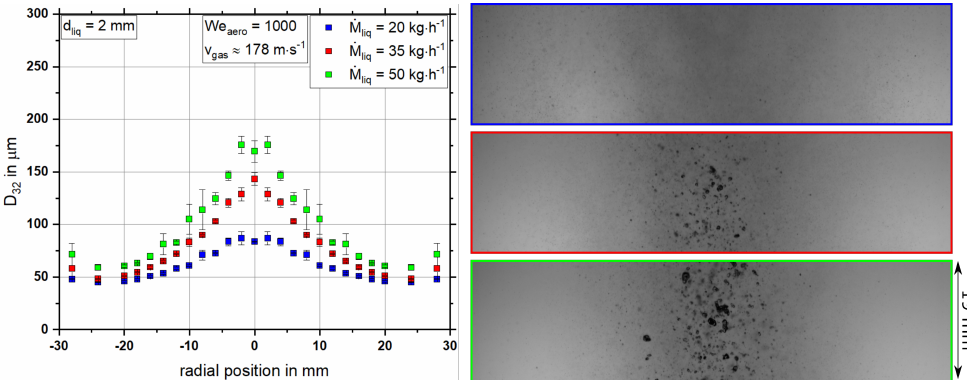
Figure 3. Radial distribution of Sauter mean diameter ( left ) and high-speed camera images at z = 130 mm ( right ) utilizing nozzle N1 at ˙ M gas = 14 kg · h − 1 , We aero = 1000 applying ˙ M = 20/35/50 kg · h − 1 liq